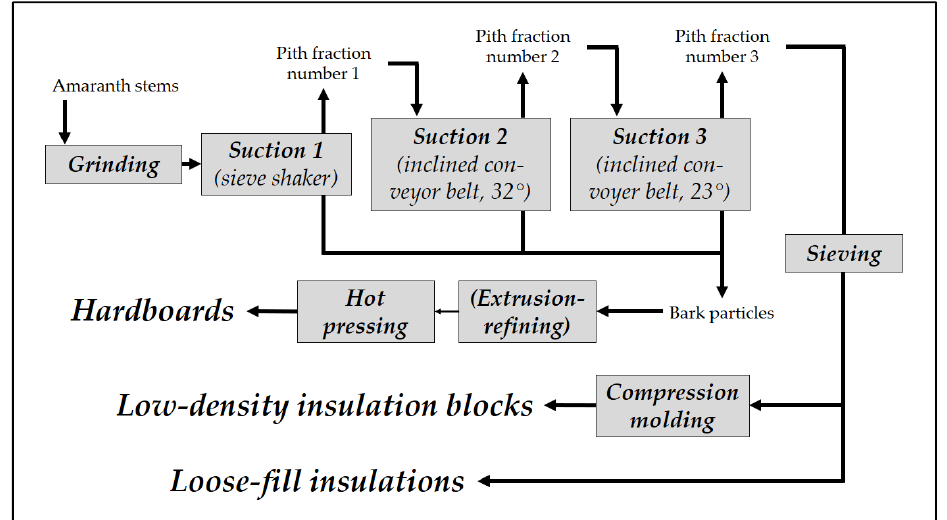
Figure 1. Schematic diagram of the fractionation process of the amaranth stems into bark and pith fractions, and building materials obtained from these fractions.